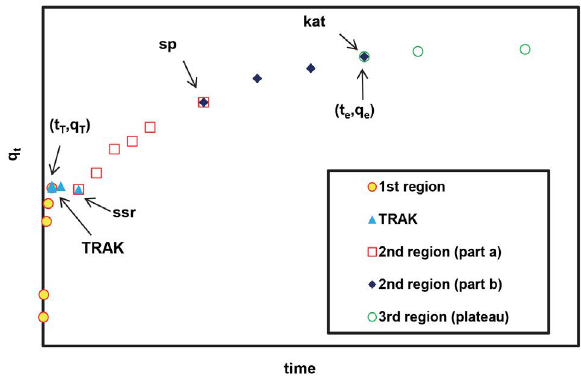
Figure 6. Typical bi-curve adsorption kinetic diagram of CR ad- sorption on Mg-Al-LDH. Different regions according to the KAS- RA model are shown in the